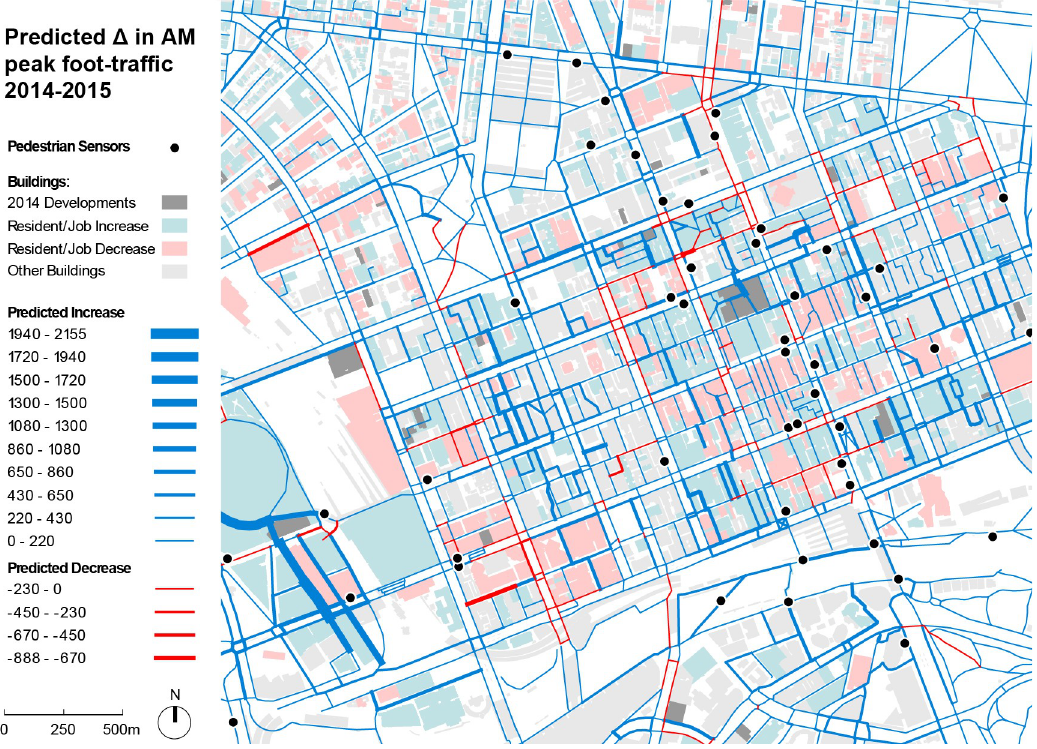
Fig 5. Predicted change in pedestrian flows during a typical workday AM peak period (8.00–9.00AM) in between June 2014 and 2015.